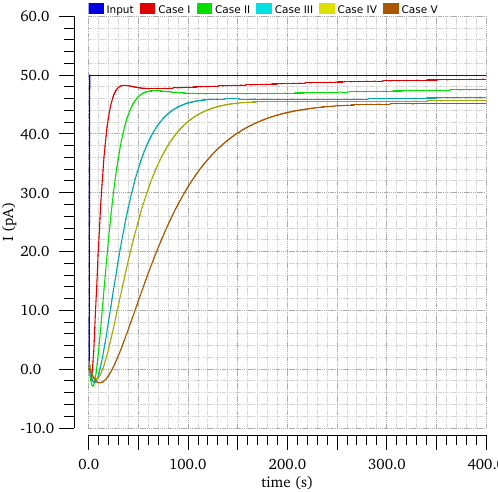
Figure 20. Step response of the controller-plant